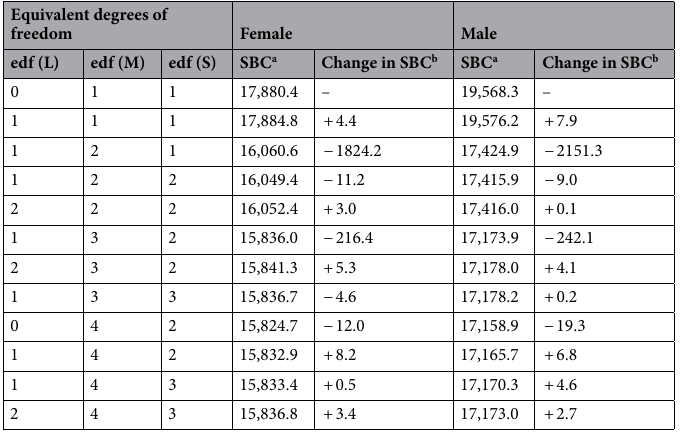
Table 1. Sequences of equivalent degrees of freedom (edf) chosen for L, M and S curve optimization process in females and males. a Schwarz Bayesian Criterion (SBC) was used as a deviance measure for checking the goodness of fit. b Change in SBC indicates the corresponding change in deviance values with the previous SBC